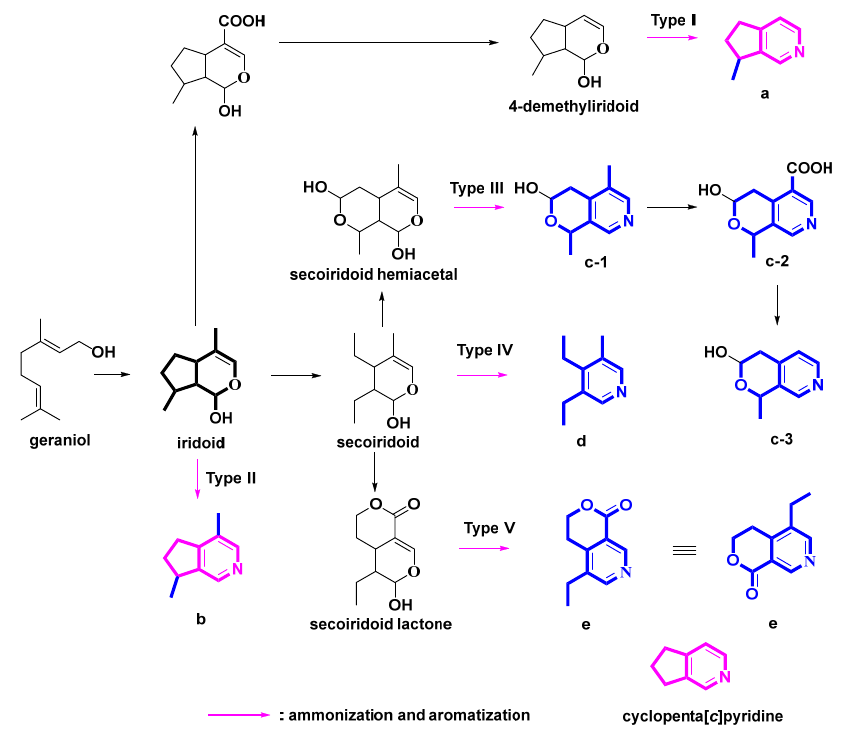
Molecules 2022 , 27 , x FOR PEER REVIEW